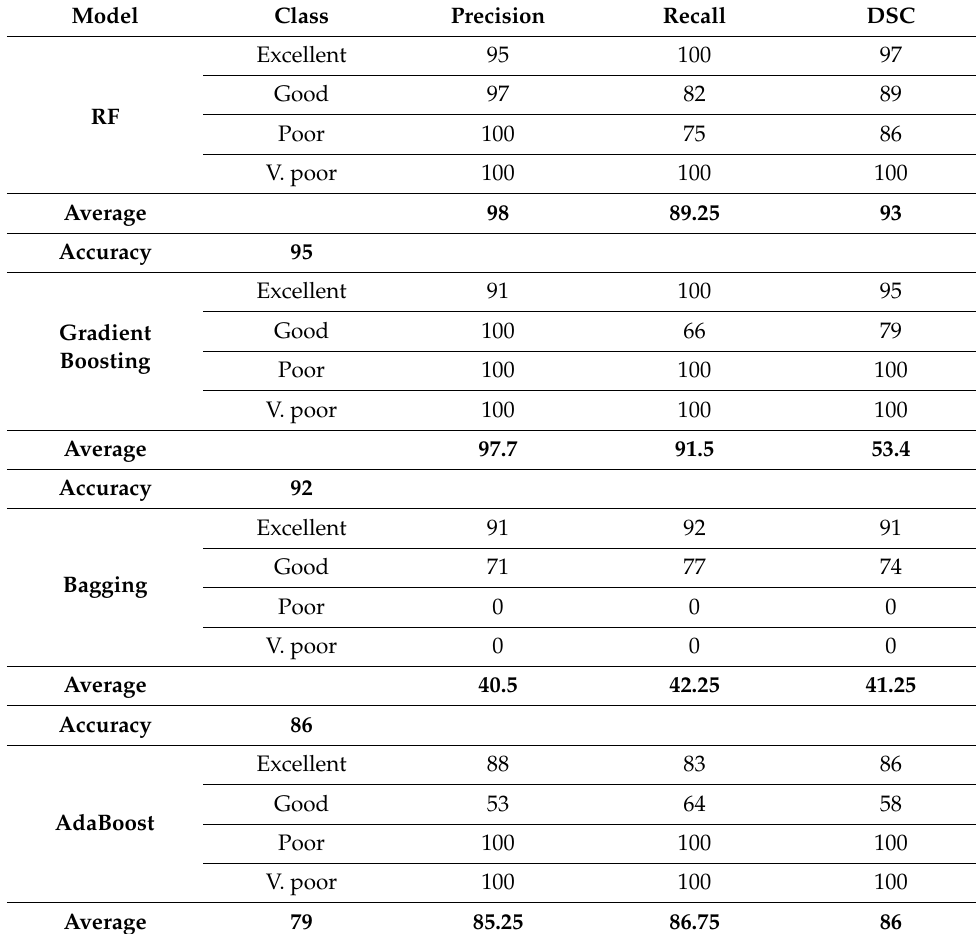
Table 3. The performance of the four ensemble models using a time-series